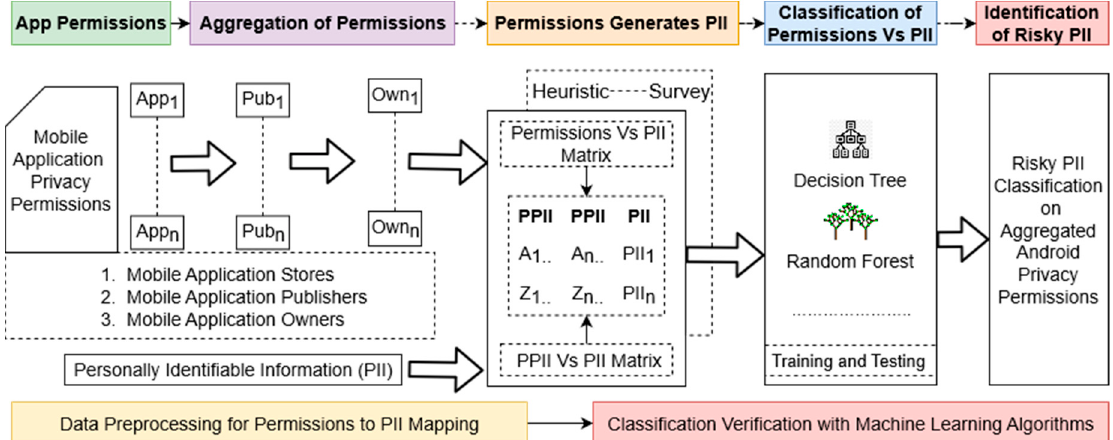
Figure 3. Overall architecture of the proposed study.